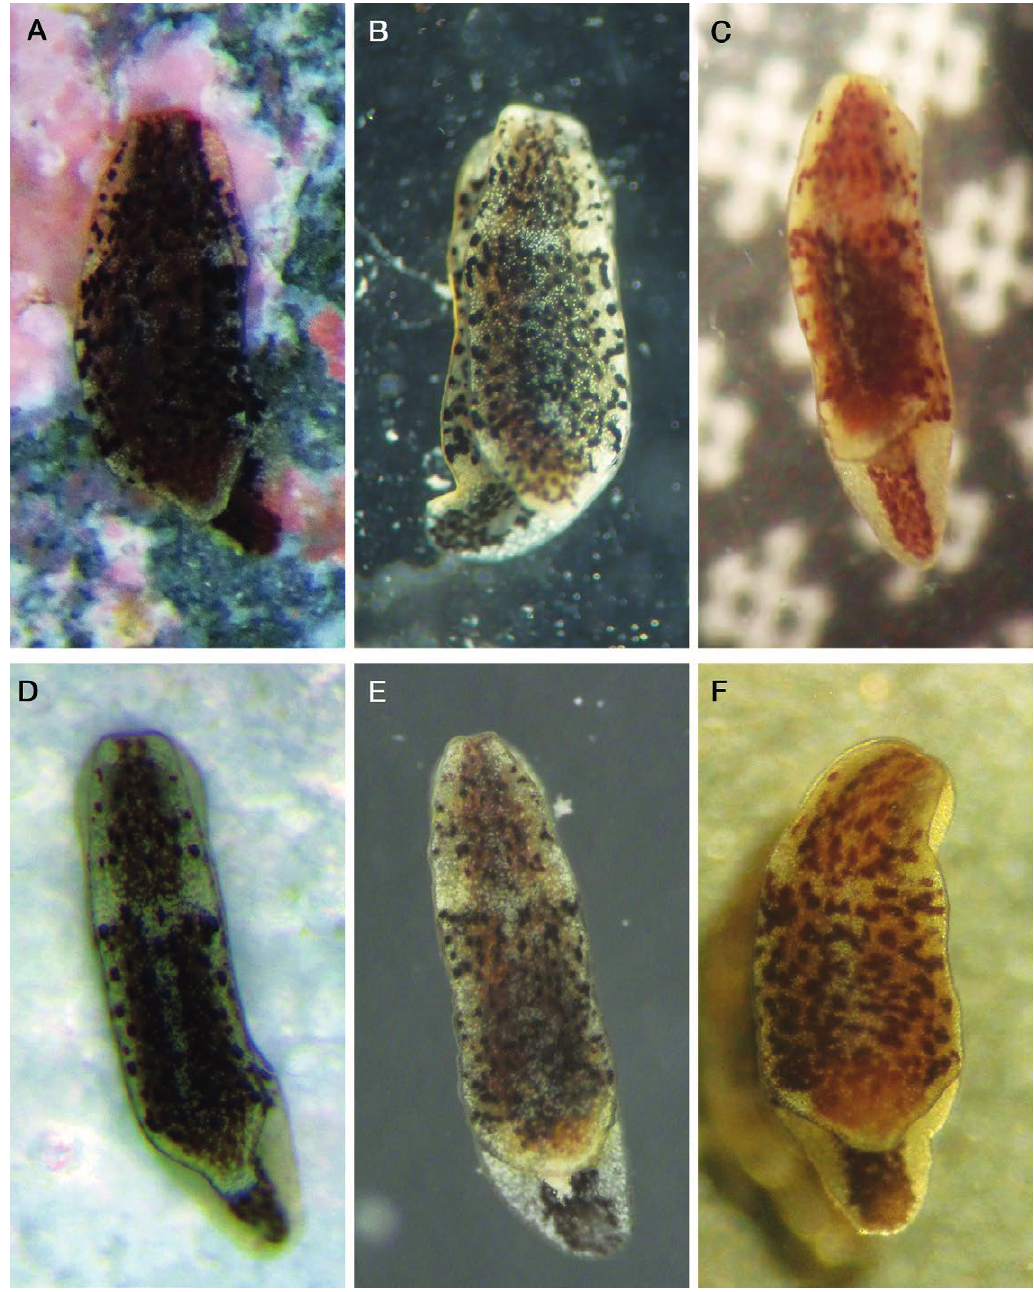
Fig. 4. – Living animals of Runcina marcosi n. sp. A (MNCN 15.05/88098), B (MNCN 15.05/88095), C (MNCN 15.05/88096), D (MNCN 15.05/88097); specimens from Catalonia, Spain (Mediterranean) (photos Marina Poddubetskaia, Ana Karla Araujo, Carles Galià). E